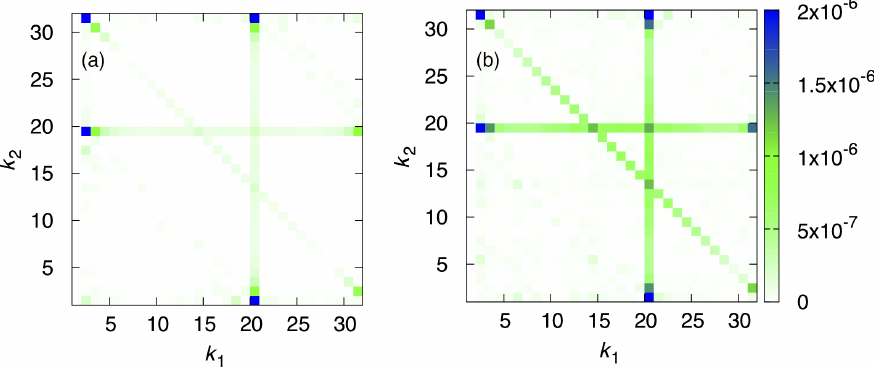
a a (cid:2) a (cid:2) k 20 . (a) ϵ ¼ 0 . 0089 , (b) ϵ ¼ 1 . 12 . Different horizontal, vertical, k 2 3 ¼ k 3 k 1 þ k 2 − k 3 i(cid:4)j with 1